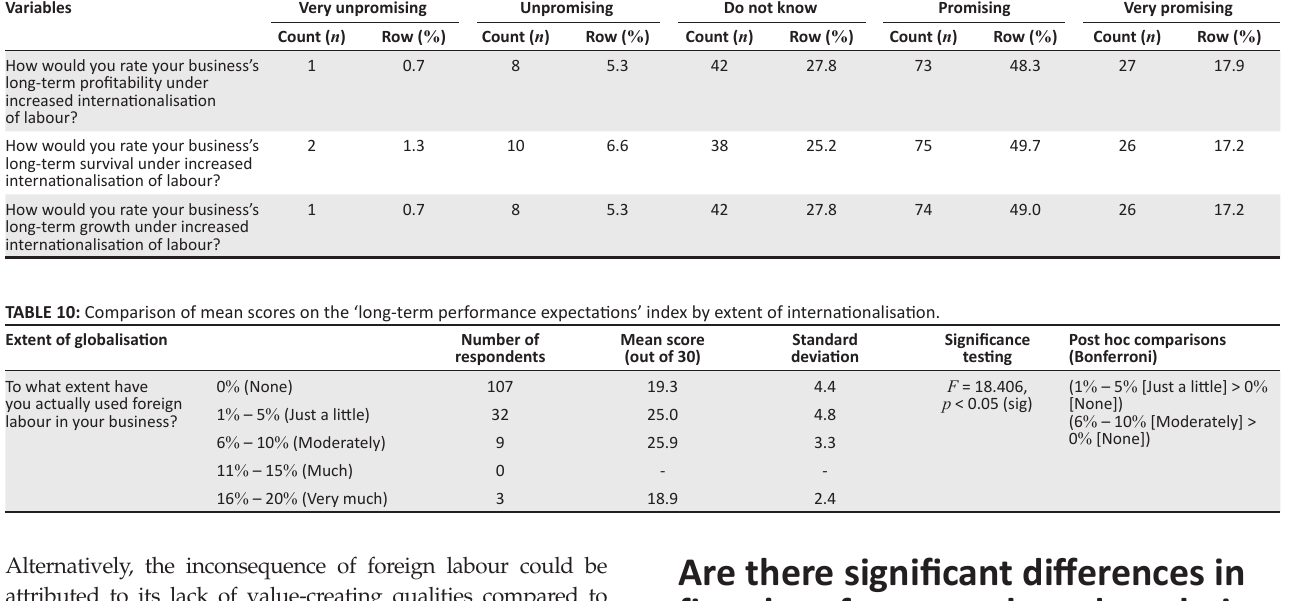
TABLE 9: Long-term expectations for business performance under increased internationalisation of labour ( N = 151). Variables